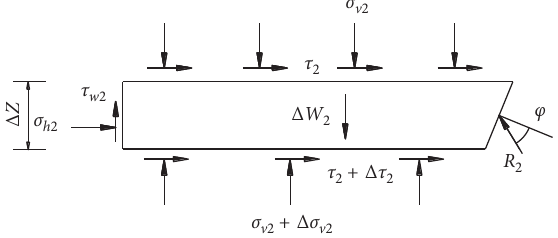
Figure 4: Forces acting on horizontal elements of zone